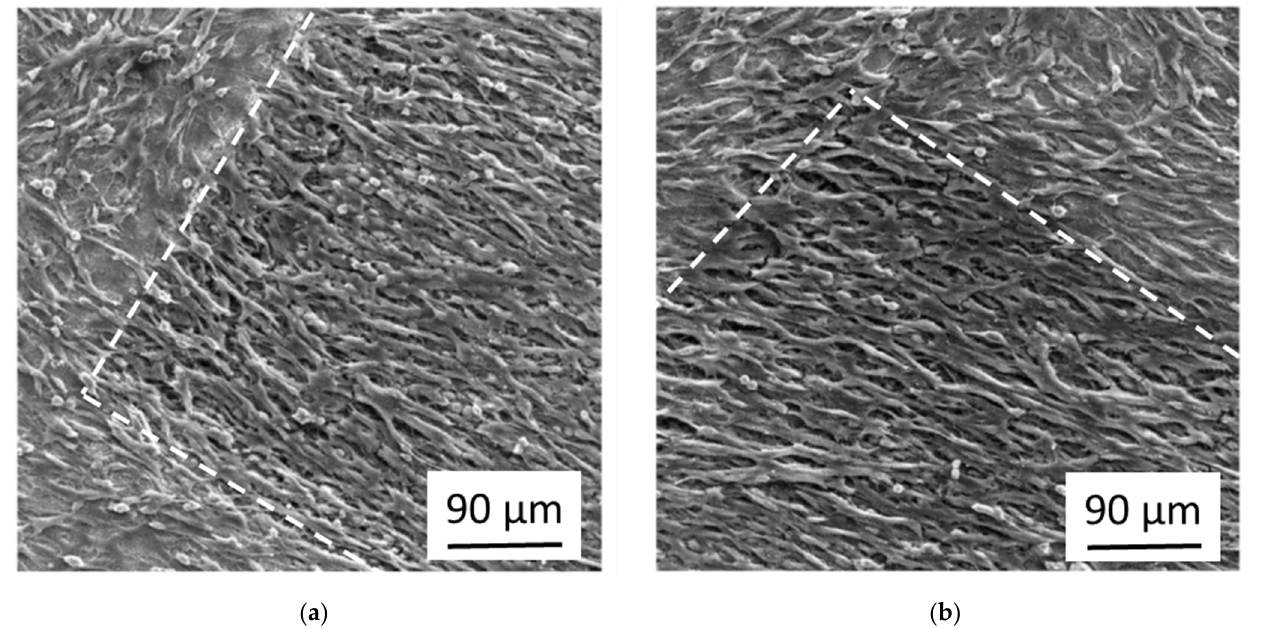
Figure 4. SEM images of the growth of osteoblasts at femtosecond laser-processed Ti-6Al-4V samples with and without sub-sequent anodization. The boundary of the laser-irradiated areas at the samples is indicated by a white dashed line. ( a ) Femtosecond laser-processing without anodization; ( b ) Femtosecond laser-processing followed by anodization.